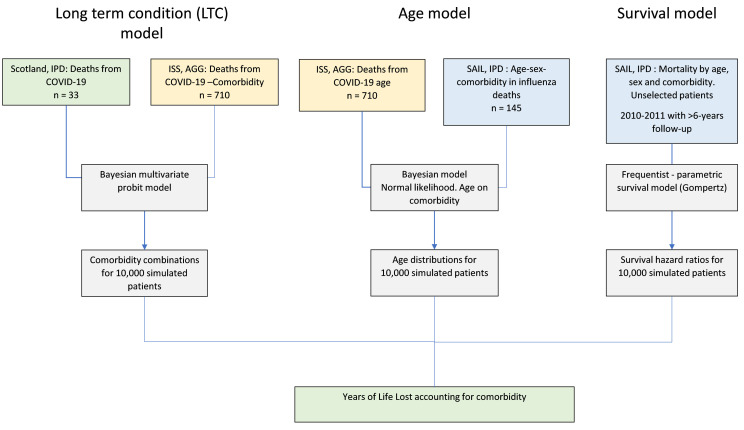
Overview of components of models.Green boxes indicate source of data/final outputs. Yellow boxes indicate Istituto Superiore di Sanità (ISS) data and blue boxes indicate Secure Anonymised Record Linkage (SAIL) data. White boxes indicate each model used to inform the final analysis. AGG - aggregate. IPD - individual level patient data.